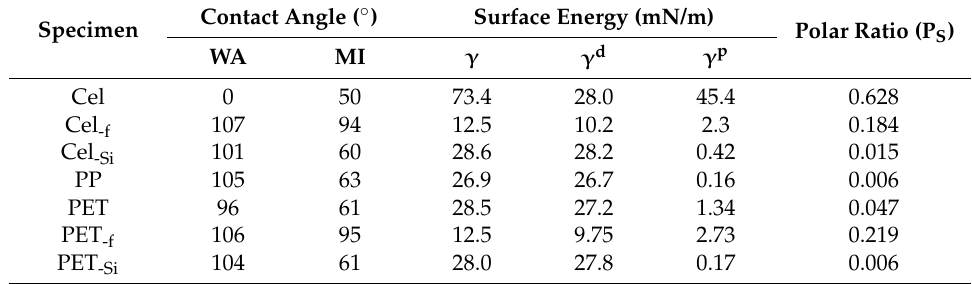
Table 4. Contact angle of water and methylene iodide, and the estimated surface